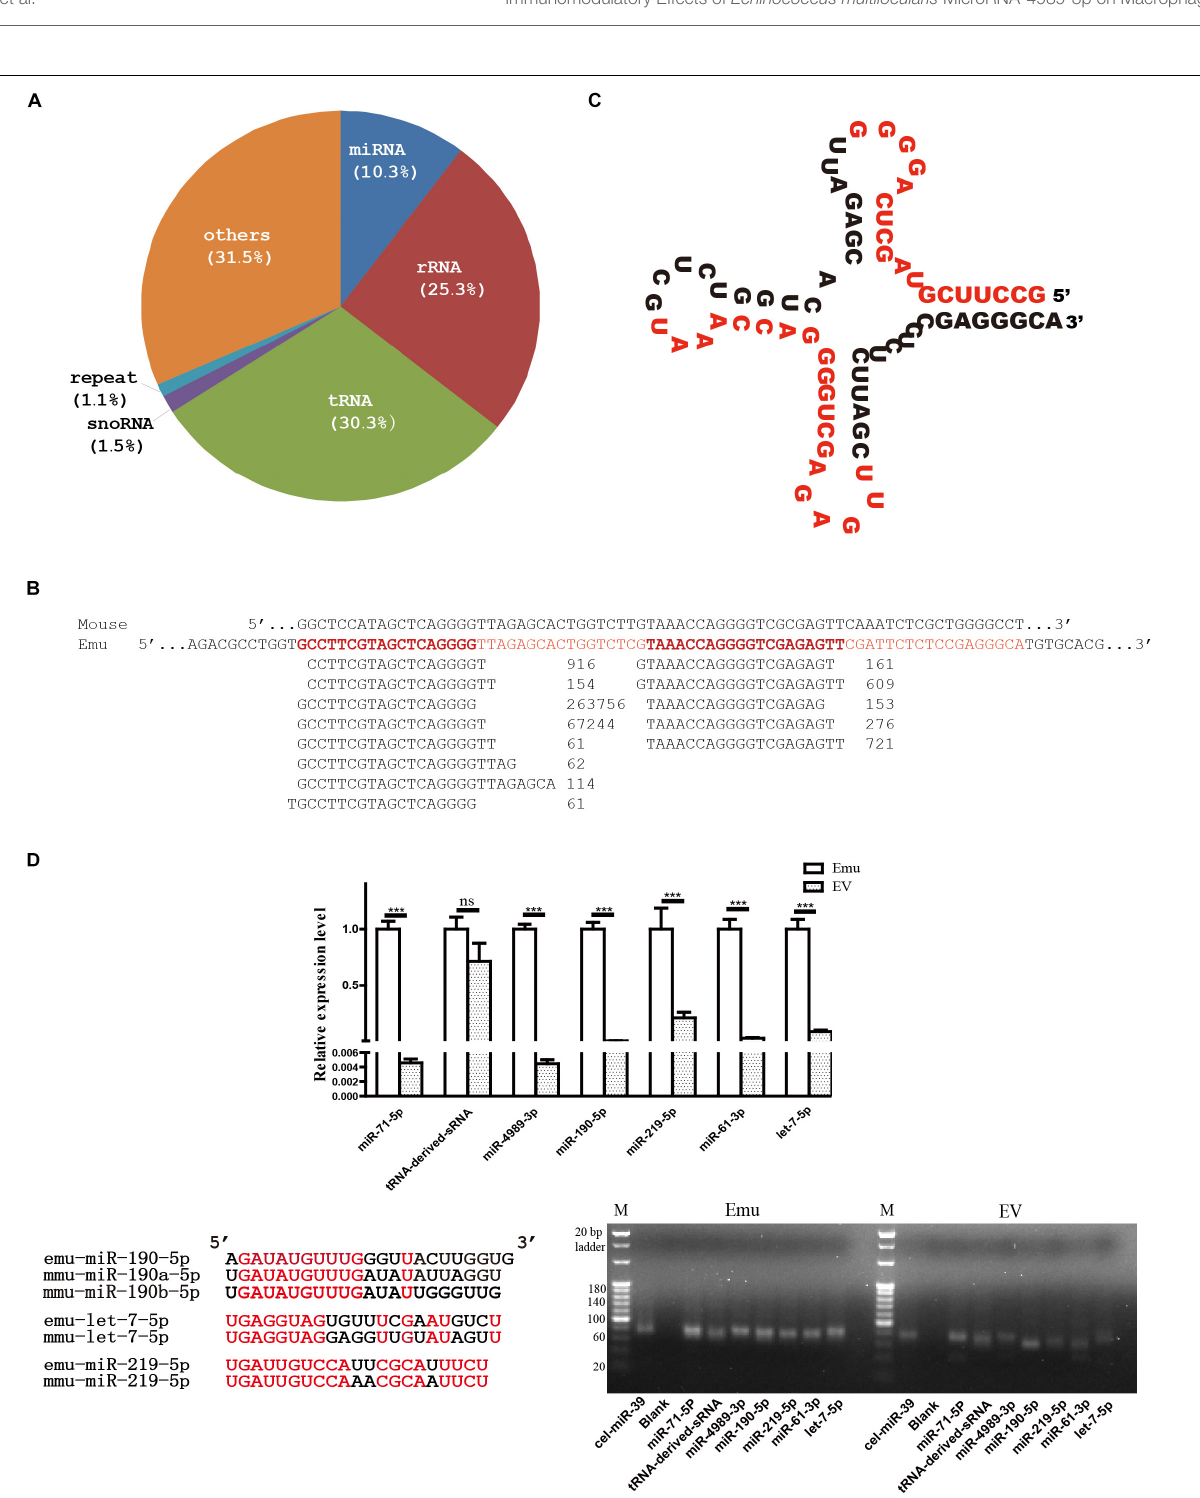
Frontiers in Microbiology |